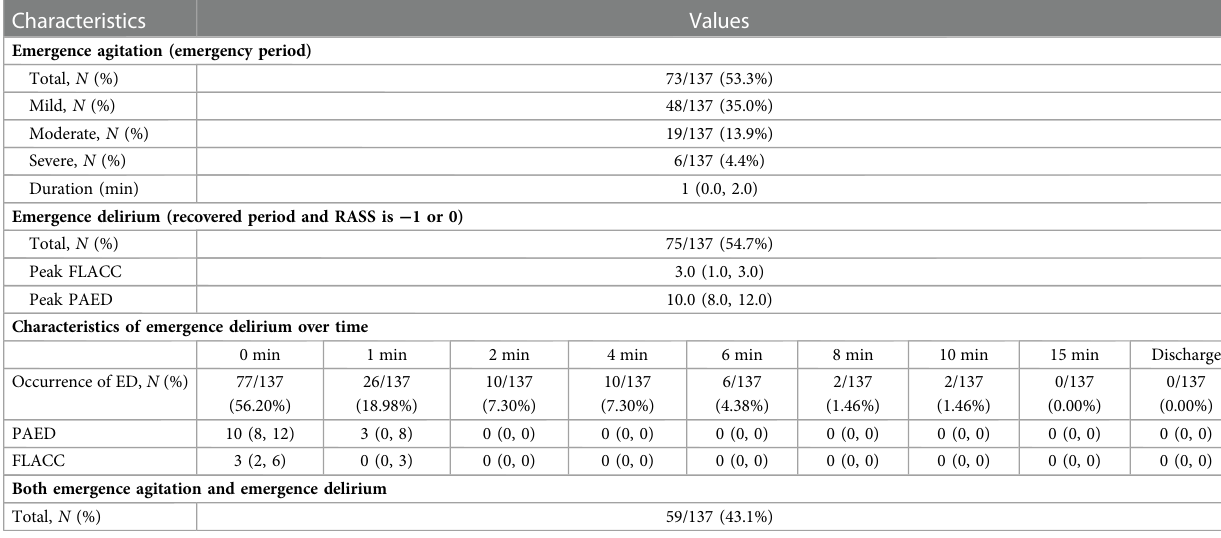
TABLE 2 Patient outcomes during emergence and recovered period.